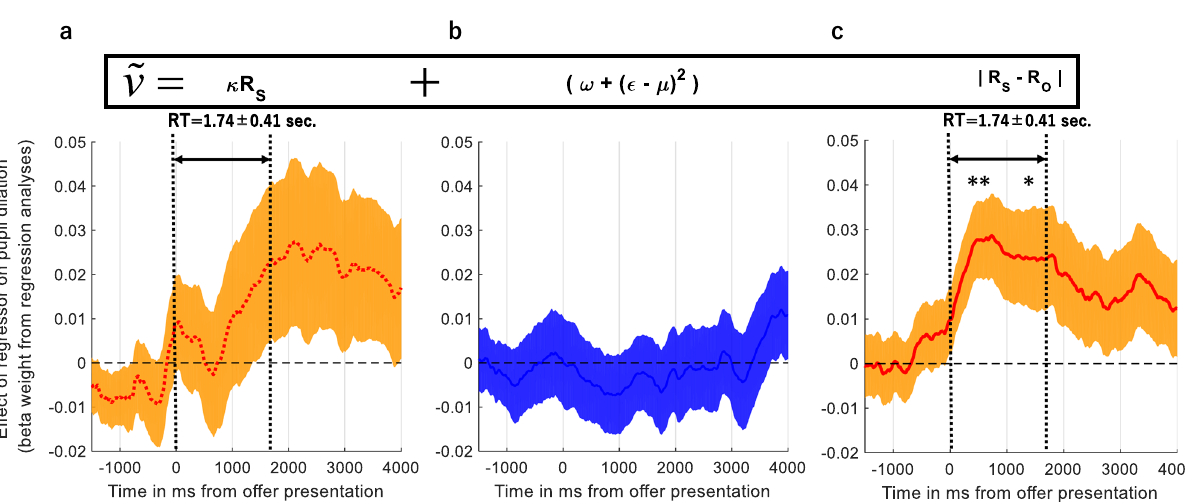
Fig. 6 Pupillary signal of subjective decision-values computed under the best- fi tting model. a Coef fi cient estimates from the pupillary OLS regression model correlating with self-reward values (i.e. the orange line and shading) ( b ) perceived emotions of the opponent which dynamically modulate the inequality term ( c ) the magnitude of self – other inequality. These panels illustrate the components of the subjective decision values. Computed under the best- fi tting model as shown above the fi gure in a black frame (also in Eq. (9)). Pupil response to inequality peaks prior to decision onset (the window marked with dashed lines designating the decision reaction time (RT)) and indicates that pupil dilates more to offers associated with greater inequality (** p < 0.01, * p < 0.05). Error shading denotes ±1 SEM across all panels. All regressors were normalised ahead of model fi tting to allow direct